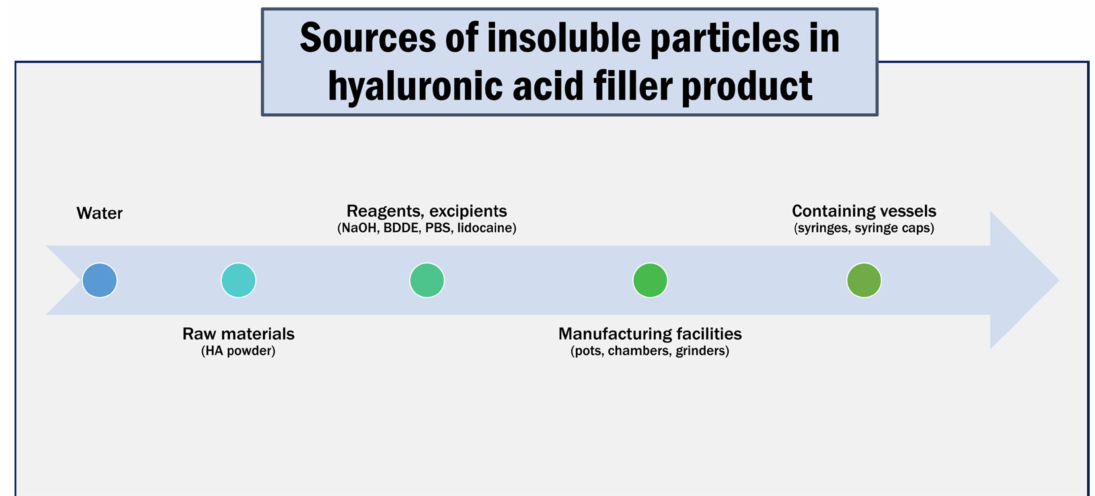
Figure 13. Common sources of